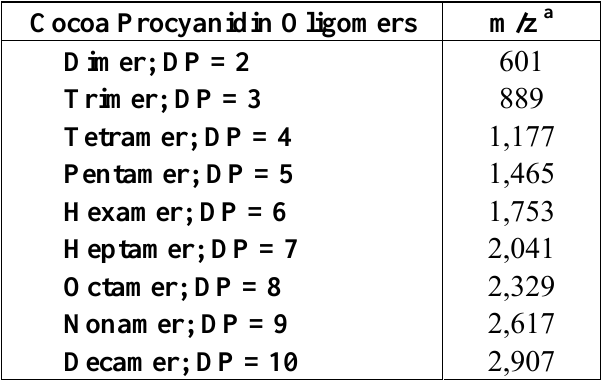
Table 1. Summary of the MALDI MS ions for the cocoa procyanidins DP = 2 through